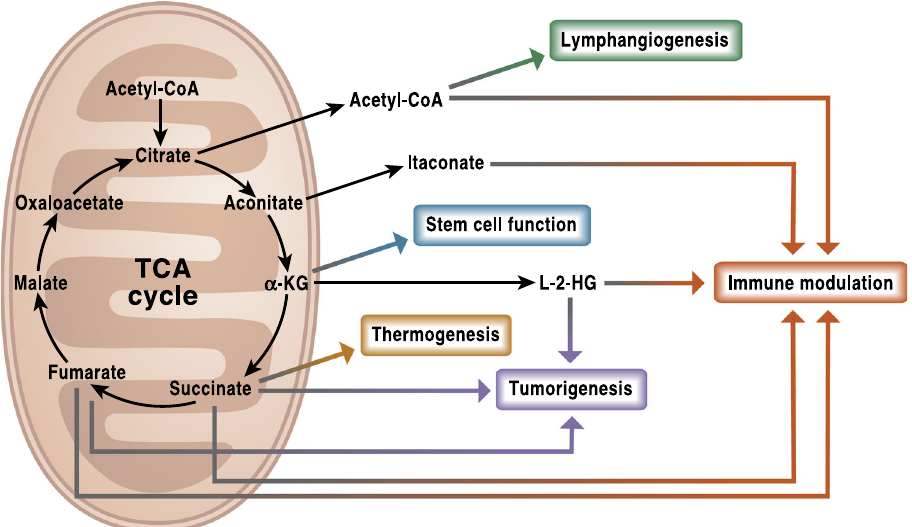
Fig. 2 The TCA cycle is a signaling hub. TCA cycle metabolites have diverse non-metabolic signaling roles with important effects in physiology and disease. Metabolites such as acetyl-CoA, itaconate, succinate, fumarate, and L-2-HG can alter the response of both the innate and adaptive immune systems. Other functions like lymphangiogenesis or the maintenance of stem cells pluripotency have been associated with acetyl-CoA and α -KG, respectively. Succinate, L-2HG, and fumarate are well recognized oncometabolites that promote tumorigenesis. In addition to its intracellular functions, succinate can also act as a systemic signal to regulate thermogenesis upon exposure to cold